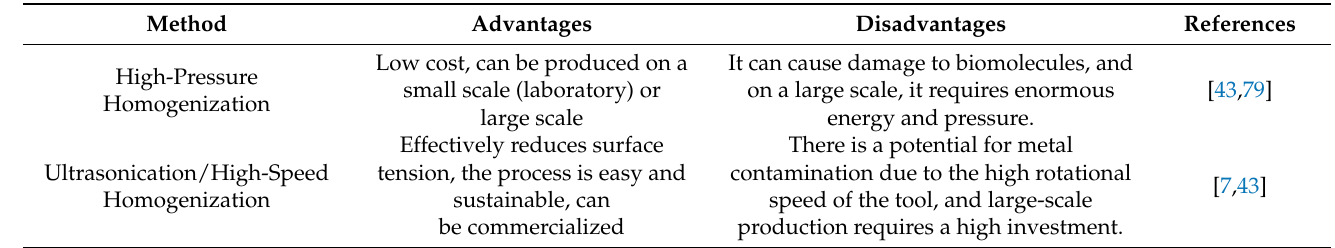
Table 3. Comparison of the advantages and disadvantages of several SLN fabrication